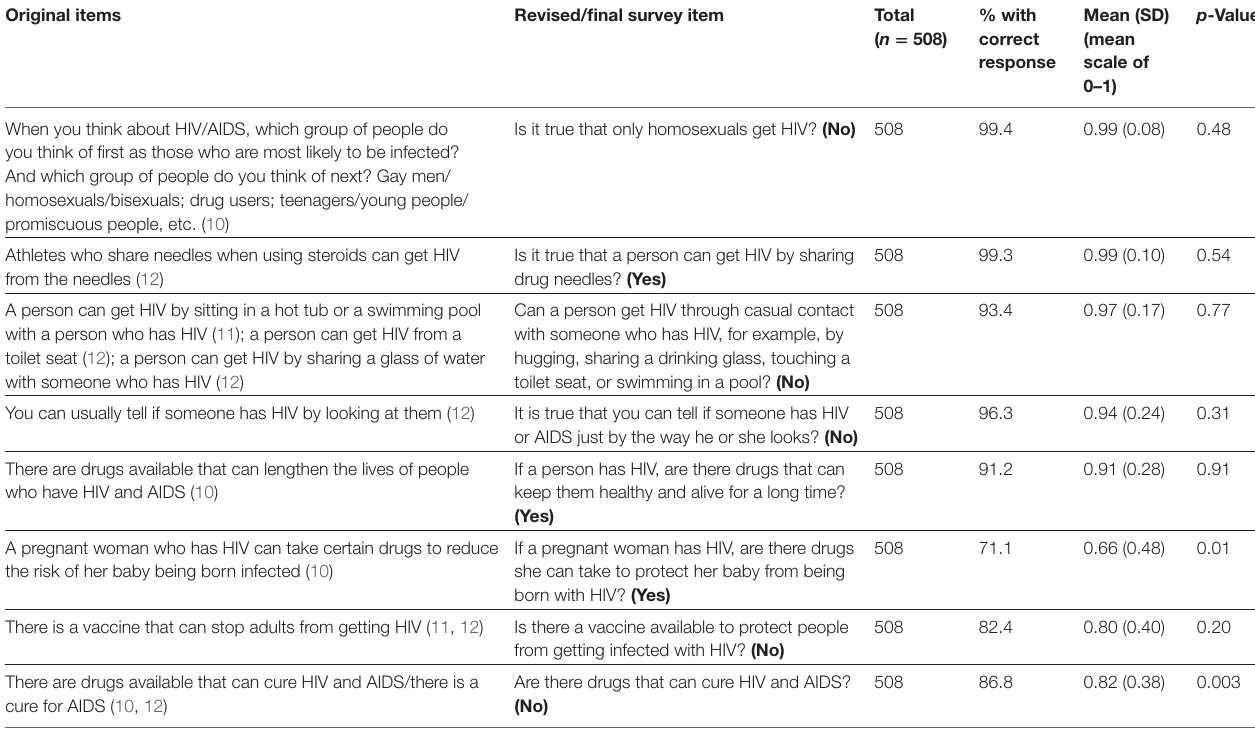
tABle 1 | Derivation of human immunodeficiency virus (HIV) knowledge items with correct responses noted and descriptive statistics. original